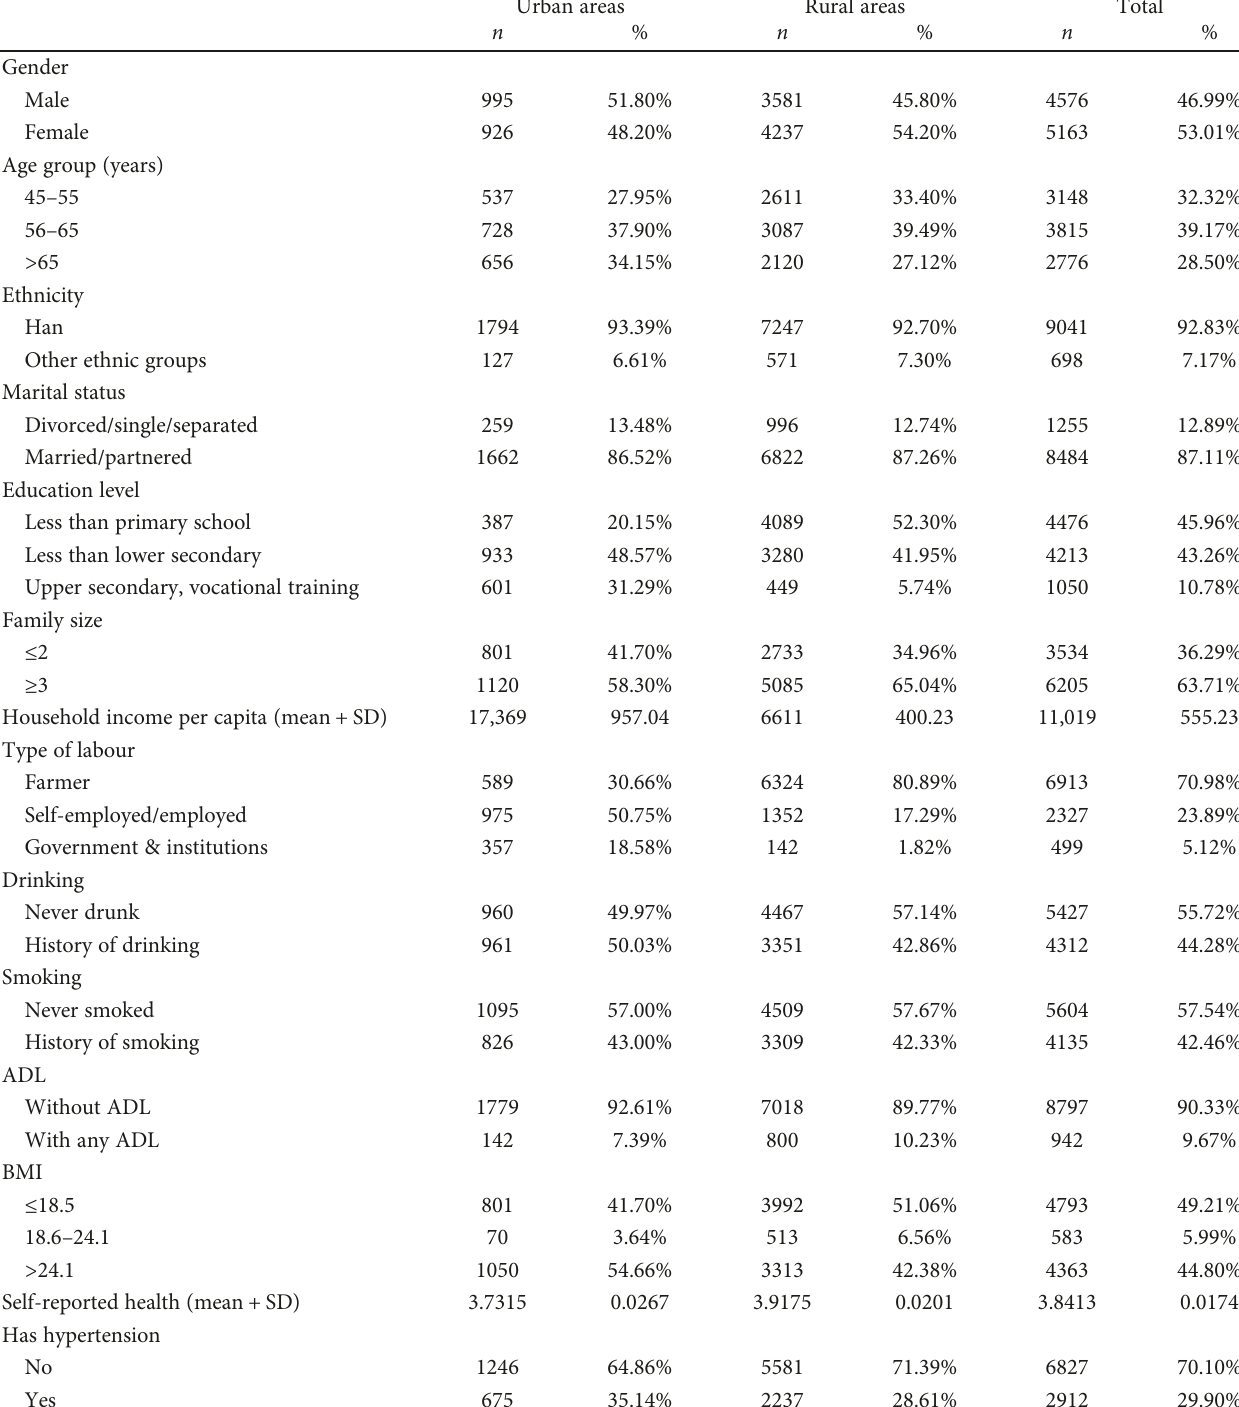
Table 1: Description of